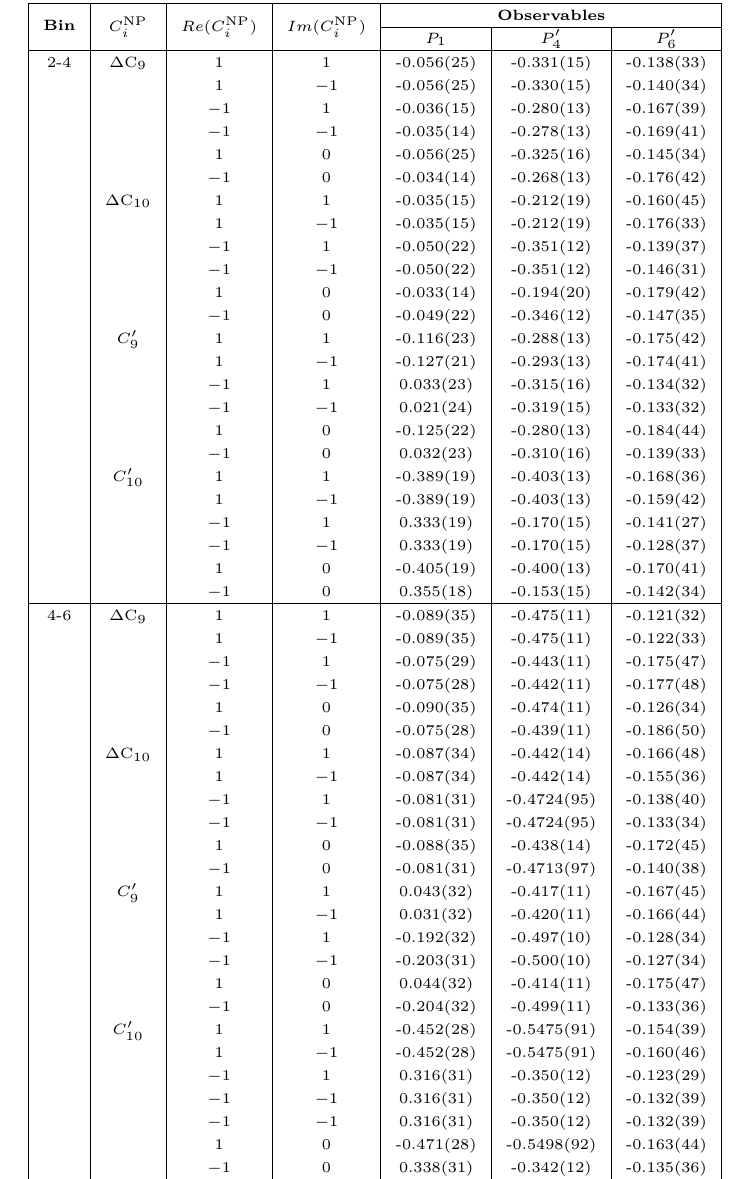
¯ B ( B ) → ρ 0 ll on the real and C 0 for the q 2 bins 2 − 4 and 4 − 6 GeV 2 for a 9 , 10 9 , 10